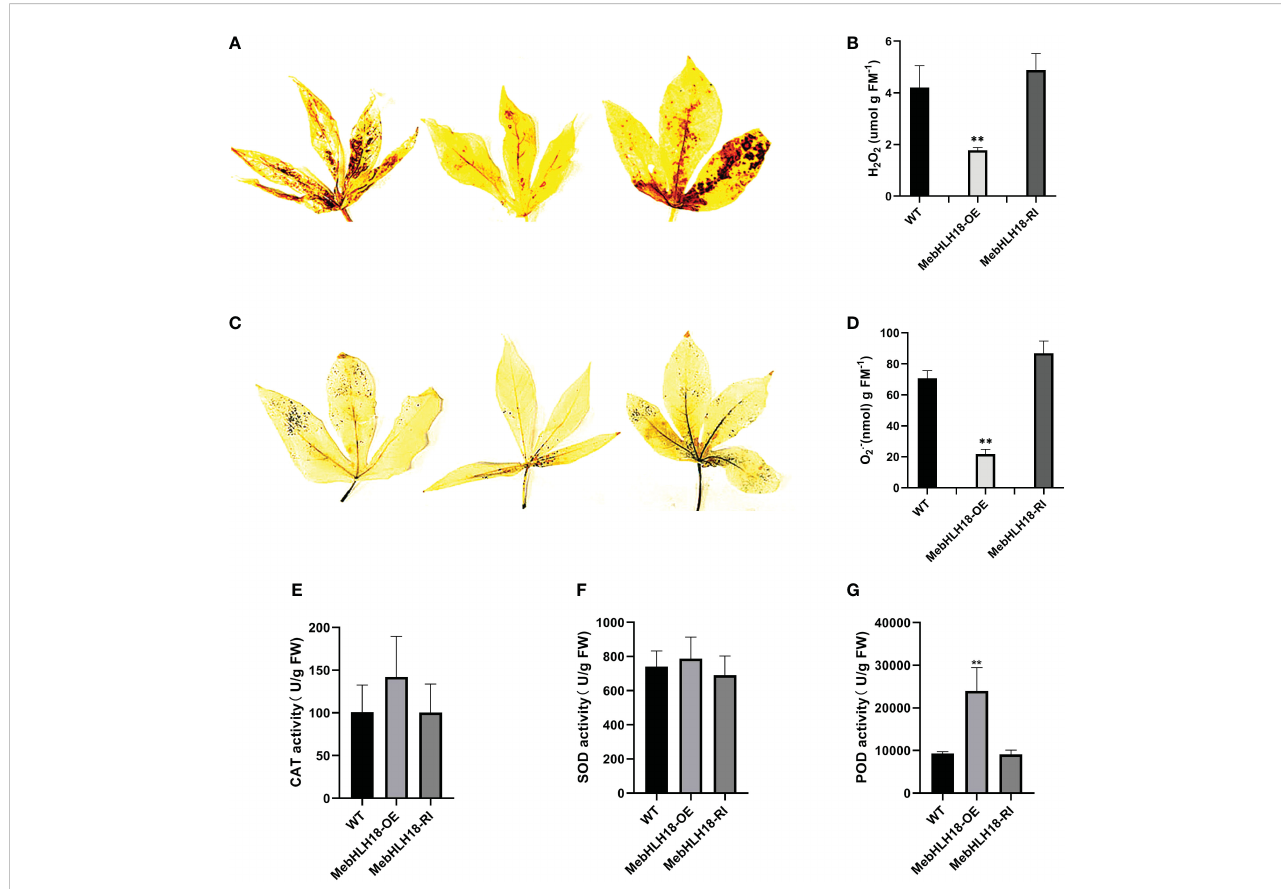
FIGURE 5 Reactive oxygen species and antioxidant enzyme activities levels in wild-type plants and transgenic lines. (A) Histochemical staining of diaminobenzidine was used to detect the in situ accumulation of H 2 O 2 in the transgenic lines and WTs after low-temperature treatment. (B) Histochemical staining of nitro blue tetrazolium was used to detect the in situ accumulation of O 2 ·- in the transgenic lines and WTs after low-temperature treatment. (C) Quantitative H 2 O 2 measurements in transgenic lines and WT plants. (D) Quantitative O 2 ·- measurements in transgenic lines and WT plants.The error bar represents three independently copied standard deviations. The asterisk indicates a signi fi cant difference between WT and transgenic lines (**P < 0.001). (E – G) Activity of catalase (CAT) (E) , superoxide dimutase (SOD) (F) , and peroxidase (POD) (G) in transgenic lines and WT after low-temperature treatment. The asterisk indicates a signi fi cant difference between WT and transgenic lines (**P <